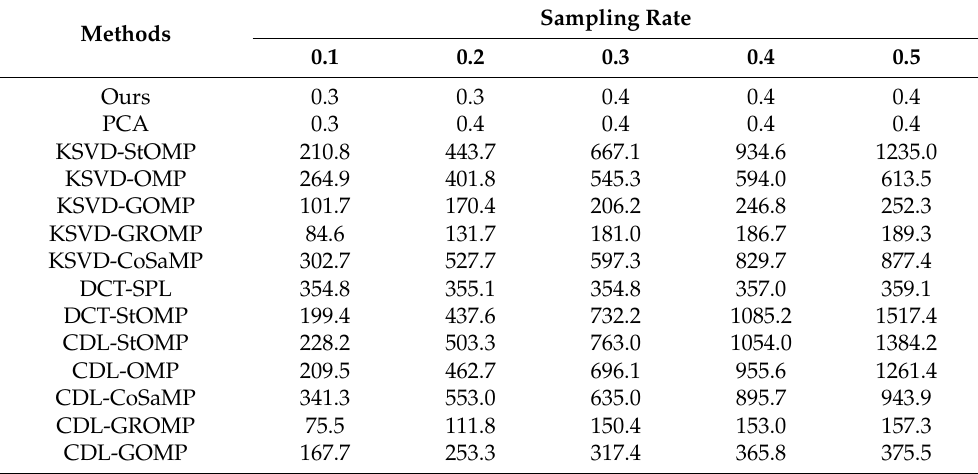
Table 3. The reconstructed average time (millisecond) of hyperspectral images in all bands under different sampling